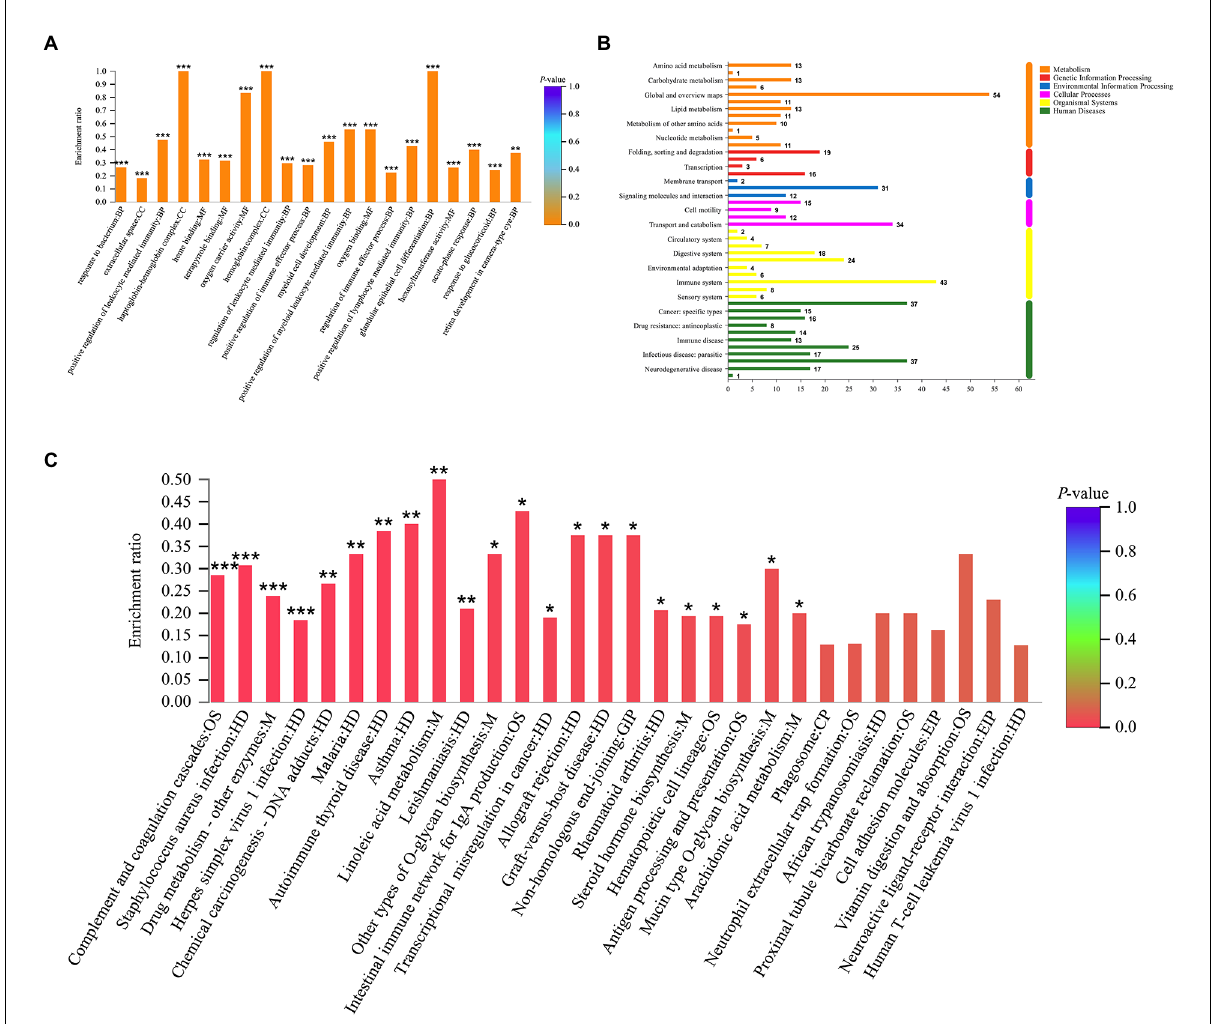
FIGURE 9 GO and KEGG analyses based on the DEPs regulated by mesalazine treatment. (A) GO enrichment analysis; (B) KEGG annotation histogram; (C) KEGG enrichment